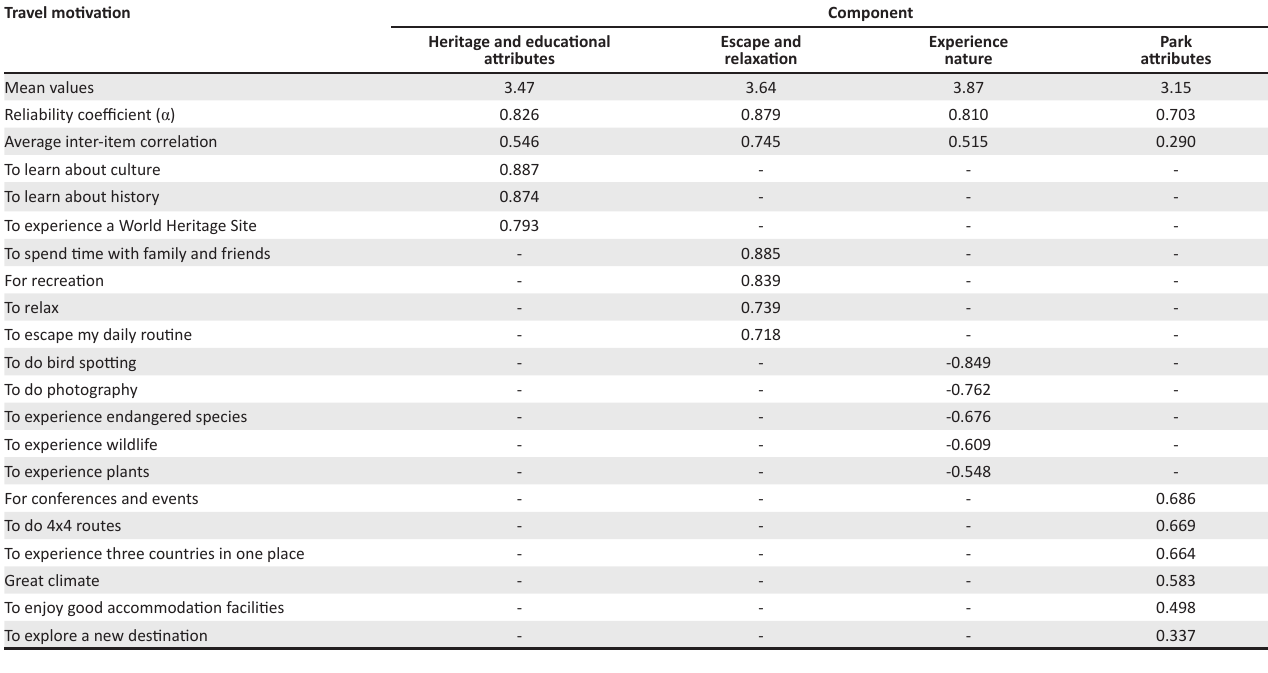
TABLE 3: Pattern matrix of visitor motivations.